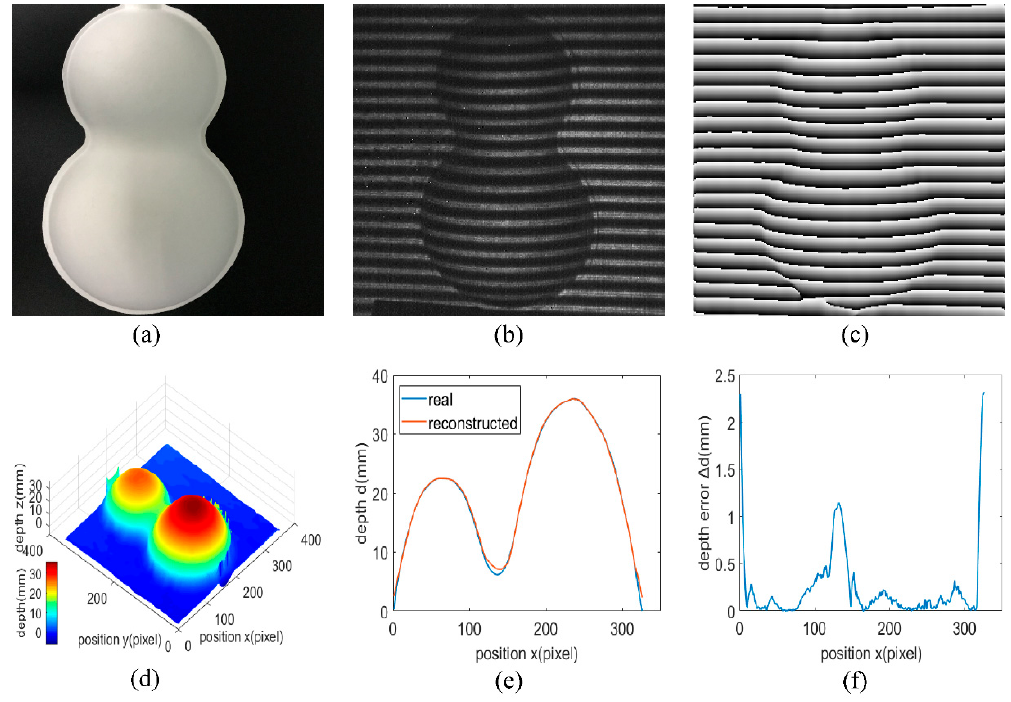
Figure 5. ( a ) Photograph of the plastic model. ( b ) 2D deformed fringe pattern of the plastic model. ( c ) 2D phase map of the plastic model. ( d ) 3D shape reconstruction image of the plastic model. ( e ) Reconstructed depth distribution versus true values at the symmetry axis of the effective part and ( f ) the corresponding depth error distribution.